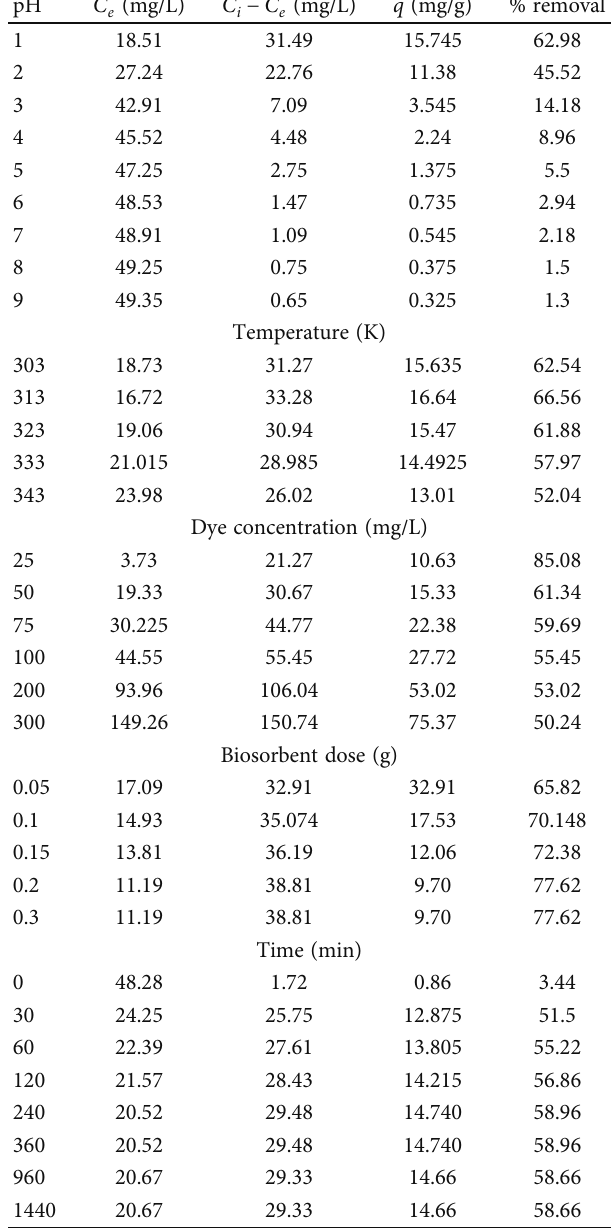
Table 5: E ff ect of pH, temperature, dye concentration, biosorbent dose, and time on the removal of Drimaren Turquoise CL-B using S. commune